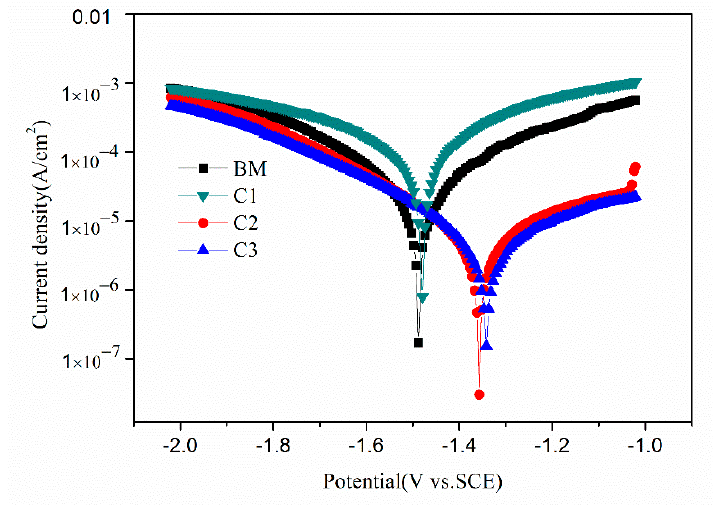
Figure 6. First-principle study of Mg 2 C 3 : ( a ) unit cell model, ( b ) electron density map, and ( c ) state density maps.